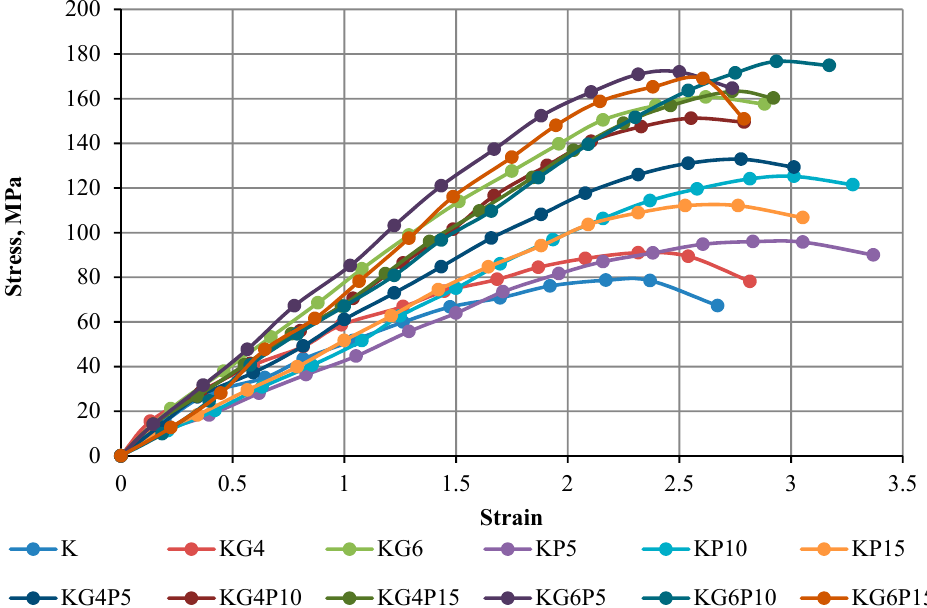
Figure 5. Stress–strain curve of kaolin and treated kaolin with gypsum and POFA with no curing—on the 1st day.